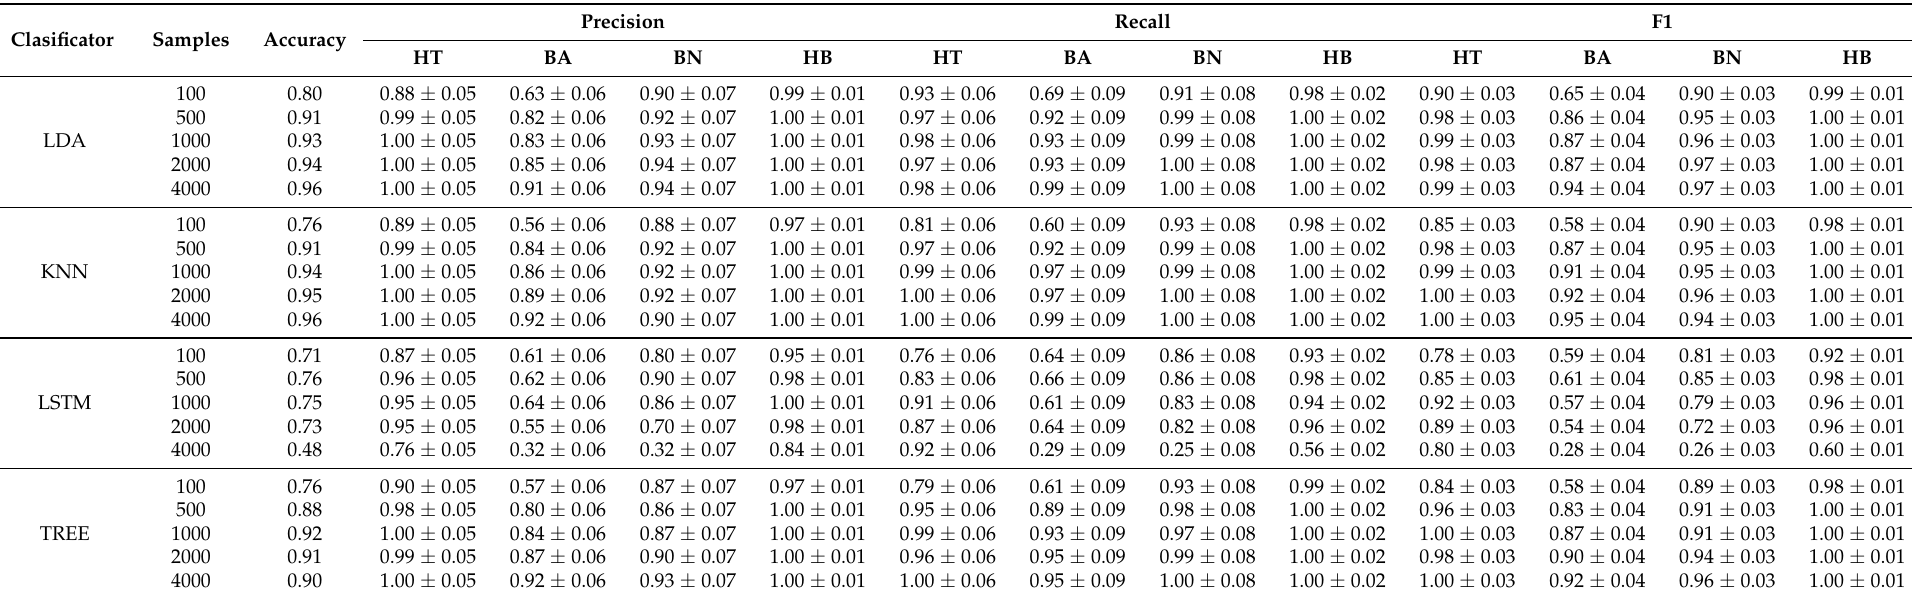
Table 2. Accuracy, precision, recall, and F1 of four single classes and six